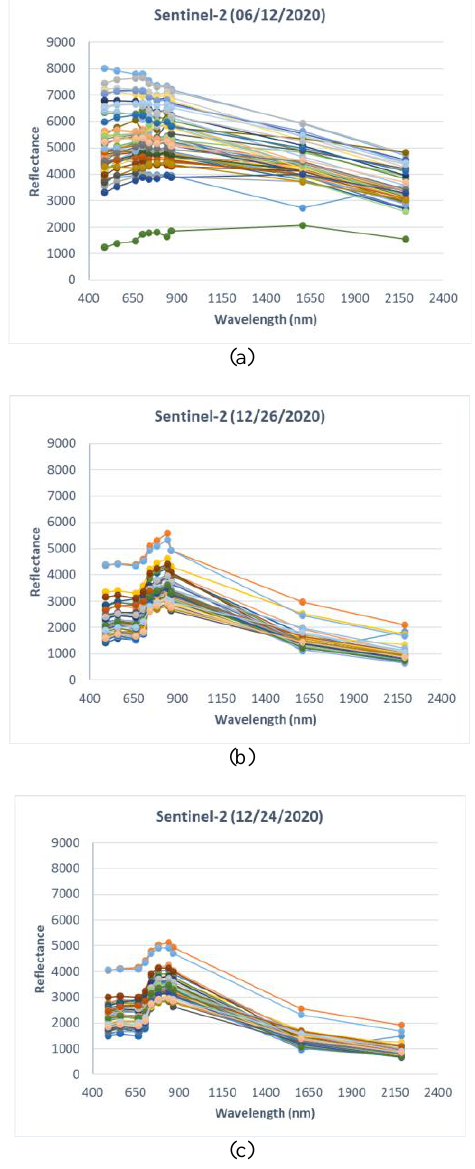
Figure 5 . Spectral signature plots extracted from S2 images for each of the 50 PCG samples. (a) Summer period. (b) and (c) Winter